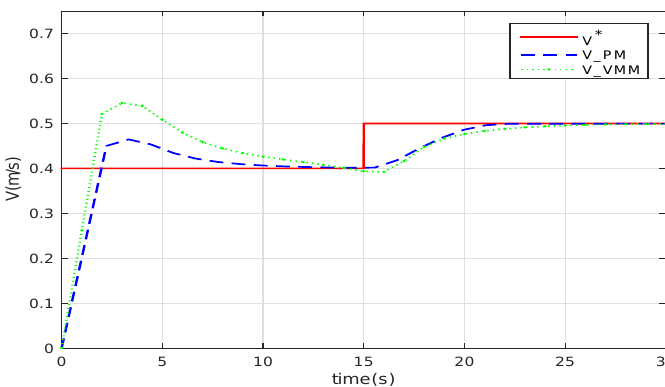
Figure 13. The speed of the robotic fish in Karman